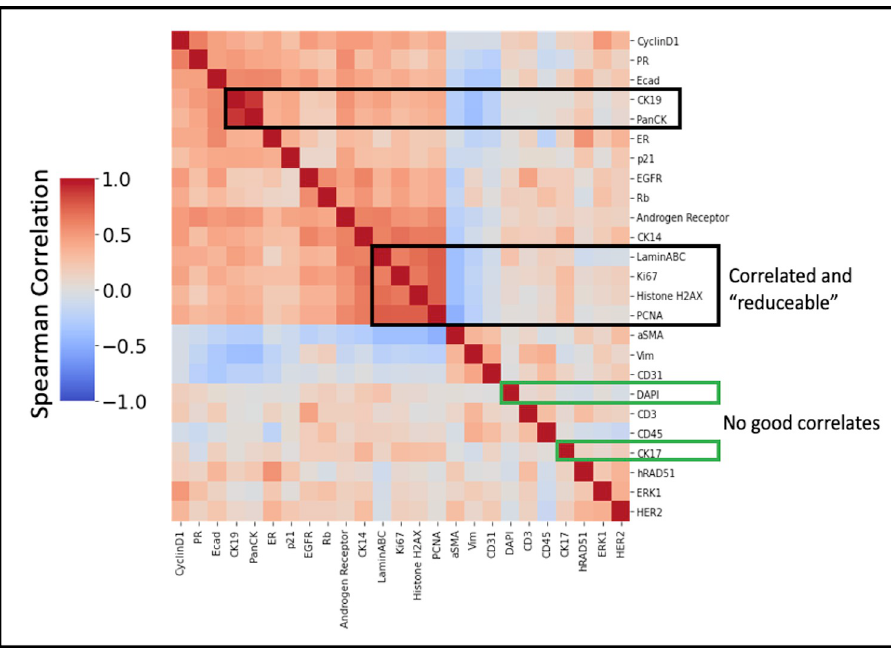
Fig 7. Heatmap of mean marker intensity correlations in the full TMA panel set, computed across single cell images. Heatmap visualization is clustered using hierarchical clustering of rows and columns. Highly correlated marker clusters show where markers can potentially predict one another and thus can be reduced. Markers with no good correlates will likely need to be included in a reduced panel as there will be no other marker that is predictive of their expression (using intensity information alone). Baseline 1-to-1 substitution will use these correlations to determine marker pairs for intensity substitution. Correlation-based selection will combinatorially create and test all possible panels of size n to determine which reduced panel produces the max correlation to all withheld